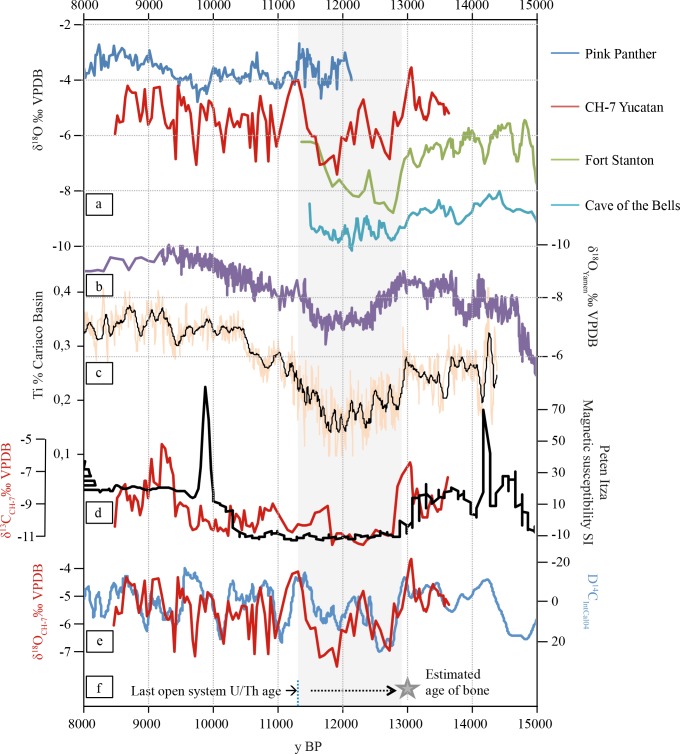
Comparison of oxygen isotope and other environmental data across the Pleistocene-Holocene boundary.a) Speleothem δ18O data (blue, red, green and light blue curve, respectively) of Pink Panther cave, Guadalupe Mountains, New Mexico, USA [51], Chan Hol cave (this study), Fort Stanton cave, New Mexico, USA [52] and Cave of the Bells, Arizona, USA [53]. b) China deglacial speleothem oxygen isotope data from Yamen Cave, Guizhou Province, China, [56] on a reversed scale; c) Cariaco Basin, Venezuela, Ti % (orange curve) overlain by moving average (black curve) [57]; d) comparison of Peten Itza magnetic susceptibility (black curve) [58] and CH-7 δ13C data (red curve); e) Covariation of CH-7 δ18O record (red line) and residual ∆14C (blue line) 1000 year moving average of IntCal04 [58–60]. Scales for two records are in opposite direction to each other to show negative correlation. Note that age models of both records are completely independent from each other; f) last closed system U/Th date (blue vertical stippled line). Extrapolation (black stippled arrow) of age model by assuming constant speleothem growth rate and interpretation of CH-7 climate signal estimates the age of the bone to around 12.8 ky (grey asterisk). All data are presented in years BP. Grey shaded interval indicates the Younger Dryas time episode.